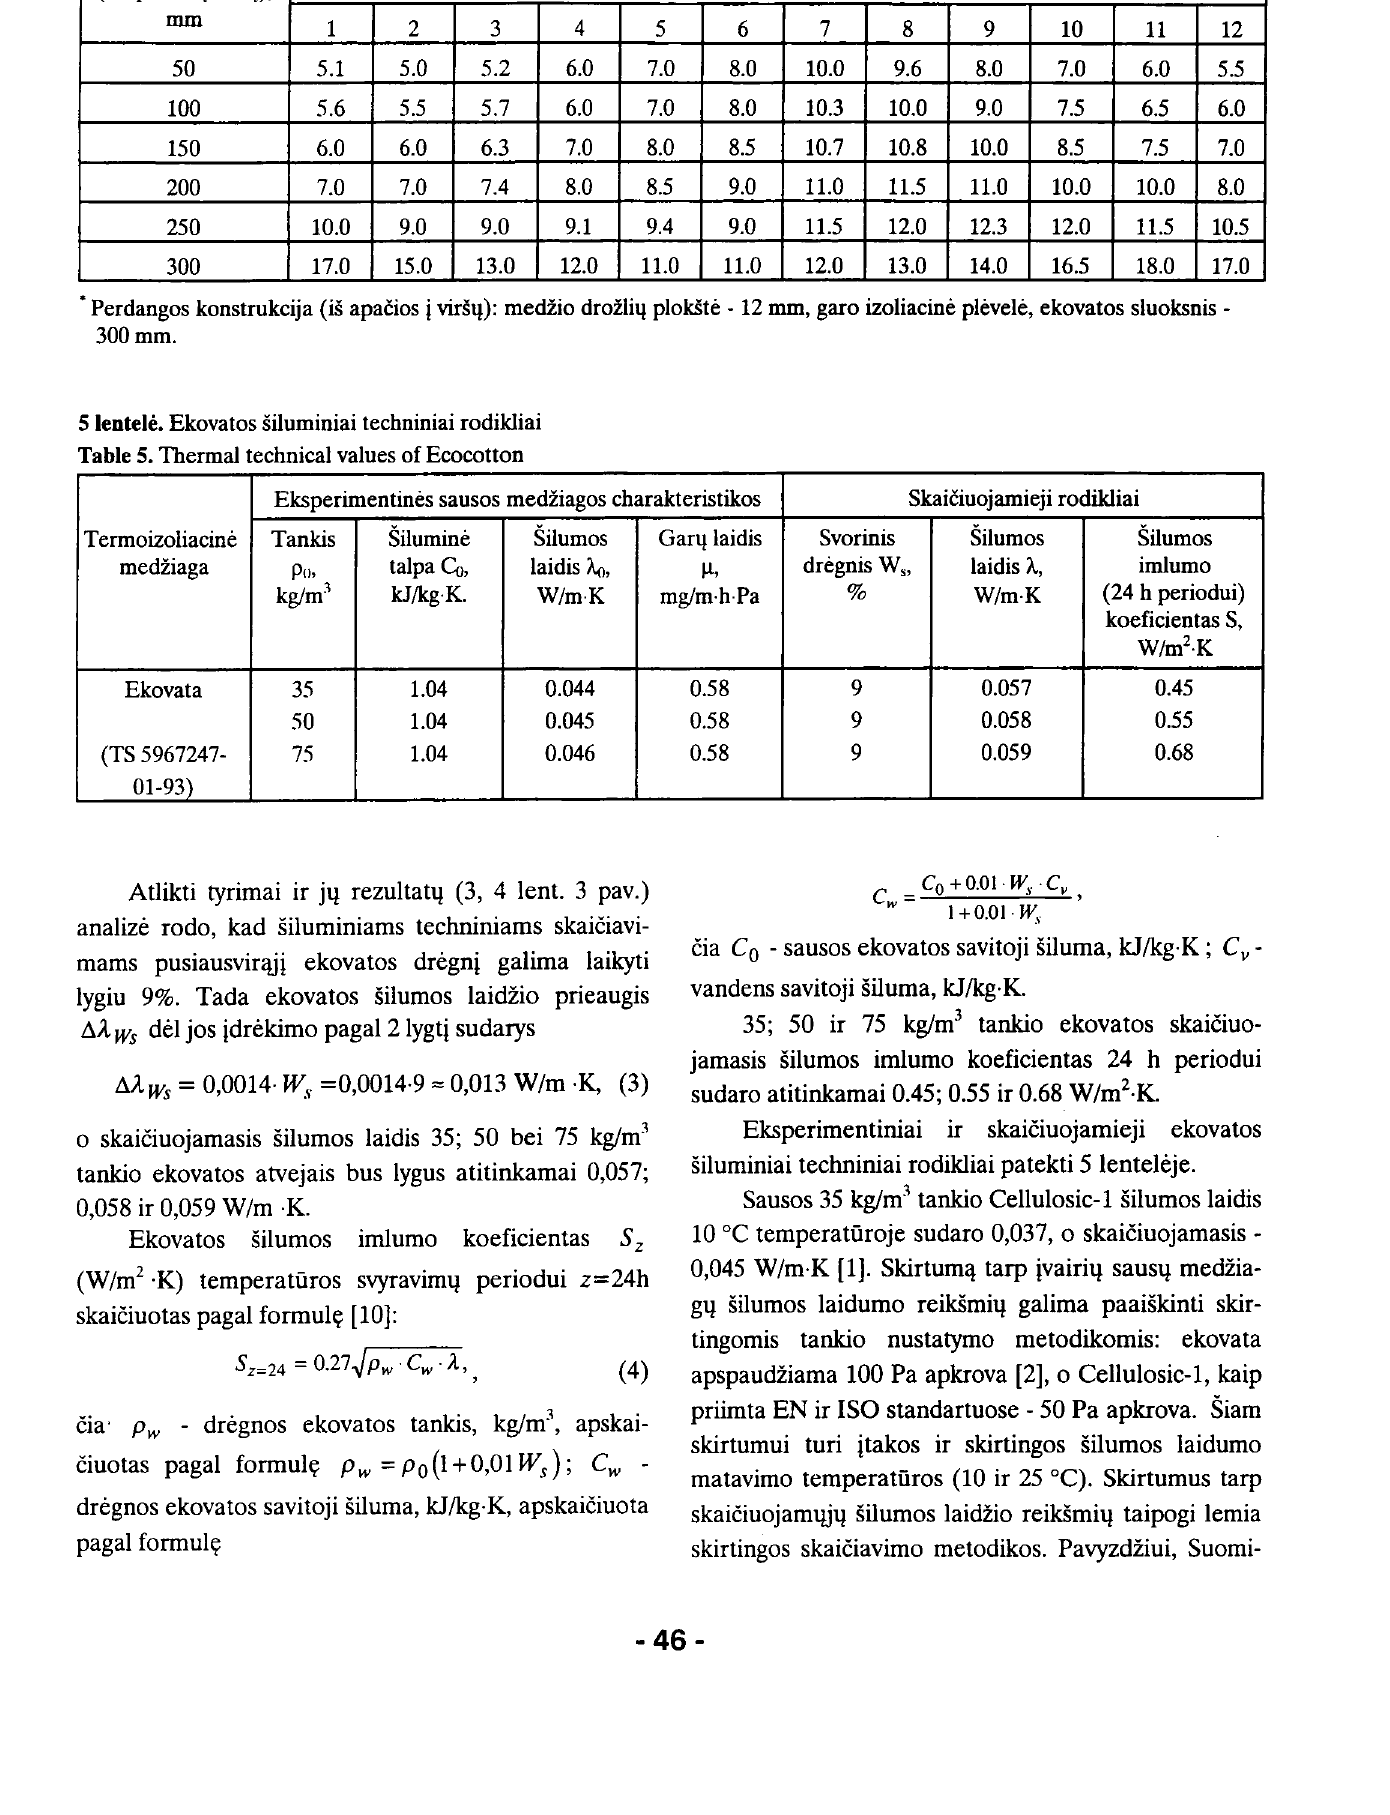
Table 4. The layeral and monthly distribution of moisture in Ecocotton Selluvilla-SV used for insulating of attic floor (Finland data) Sluoksnis, kuriame nustatytas dregnis Ekovatos mases dregnio pasiskirstymas pagal menesius, %